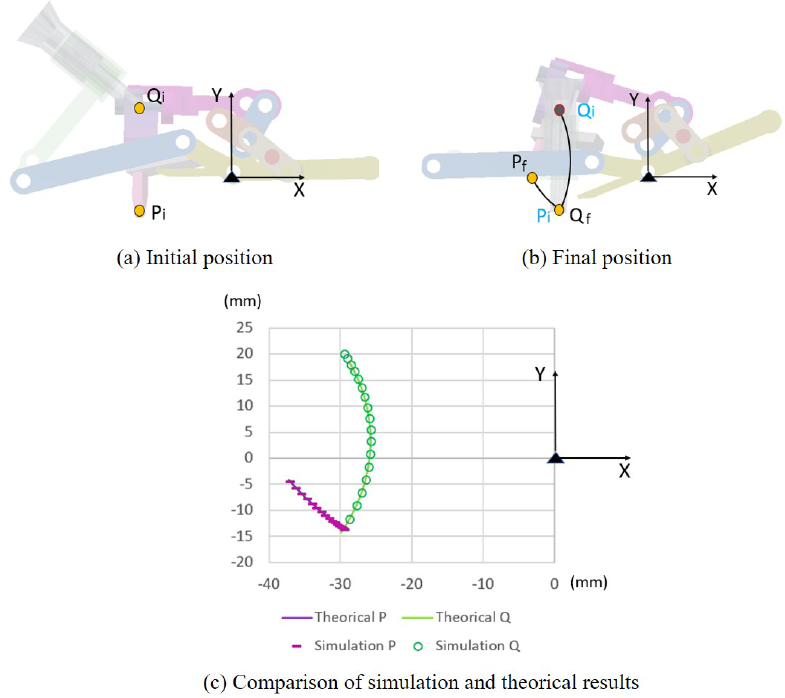
Figure 7. Paths of points P and Q . Table 2. IT8 errors. Dimension Error Dimension Error Dimension/angle